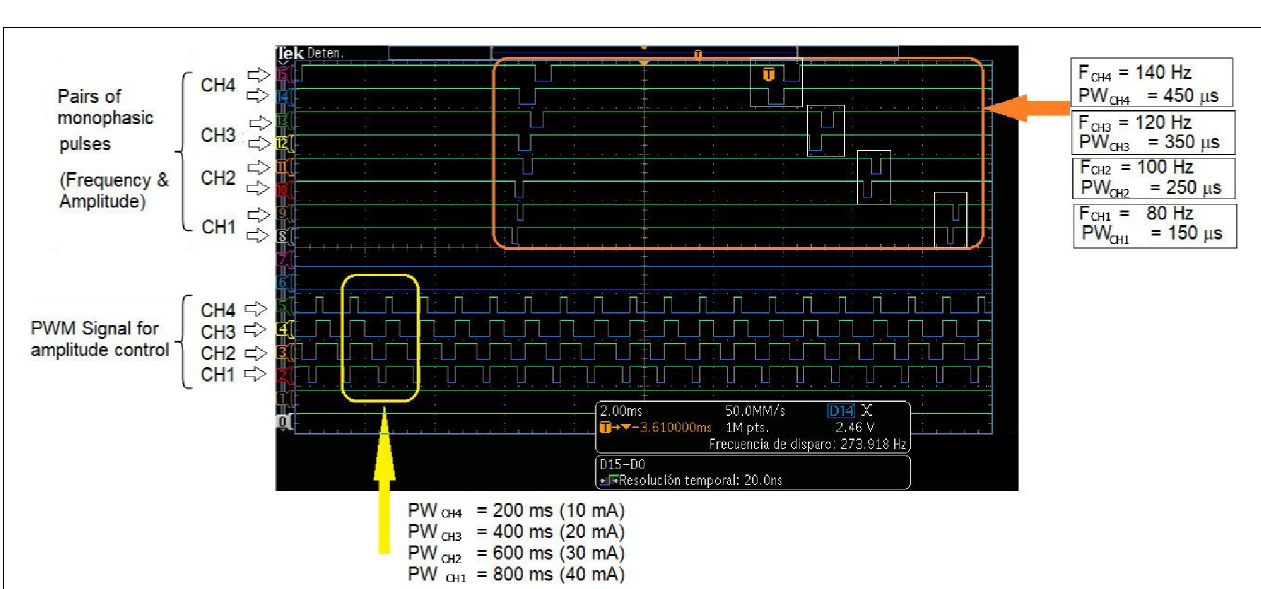
FIGURE 5 | Simultaneous modulation of pairs of two stimulation parameters with the PG-nFES. (A) Frequency and Amplitude Modulation, (B) Frequency and Pulse Width Modulation, (C) Amplitude and Pulse Width Modulation. In the corresponding column for each incise, the upper plot illustrates the slow changing modulation (0.5 Hz) of one parameter (amplitude or frequency), and the bottom plot shows the modulation of the other parameter (amplitude or pulse width).